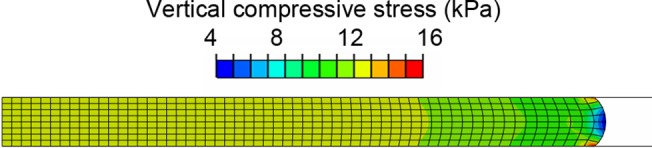
Typical distribution of vertical compressive stress (S22 in ABAQUS) from the axisymmetric FE simulation (therefore only the right half of the skin middle-section is shown), with friction coefficient of 0.3 and skin thickness of 400 μm.Note that there is only minor edge effect around the periphery.